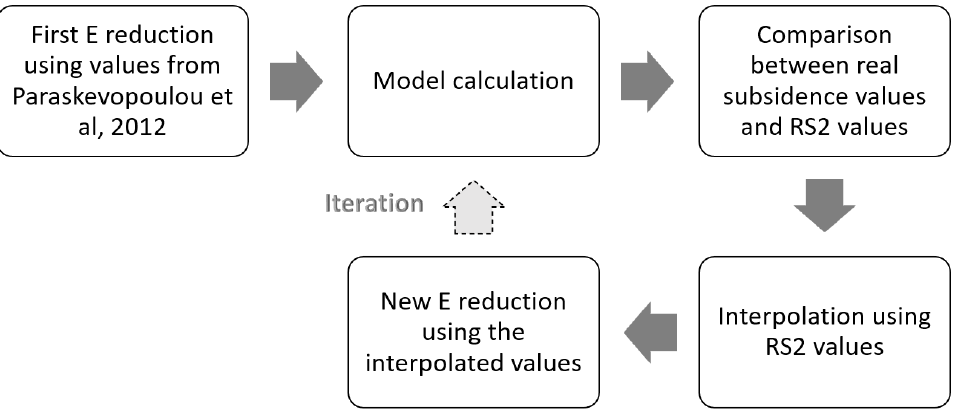
Figure 6. The methodology followed to define Young’s modulus decrease.